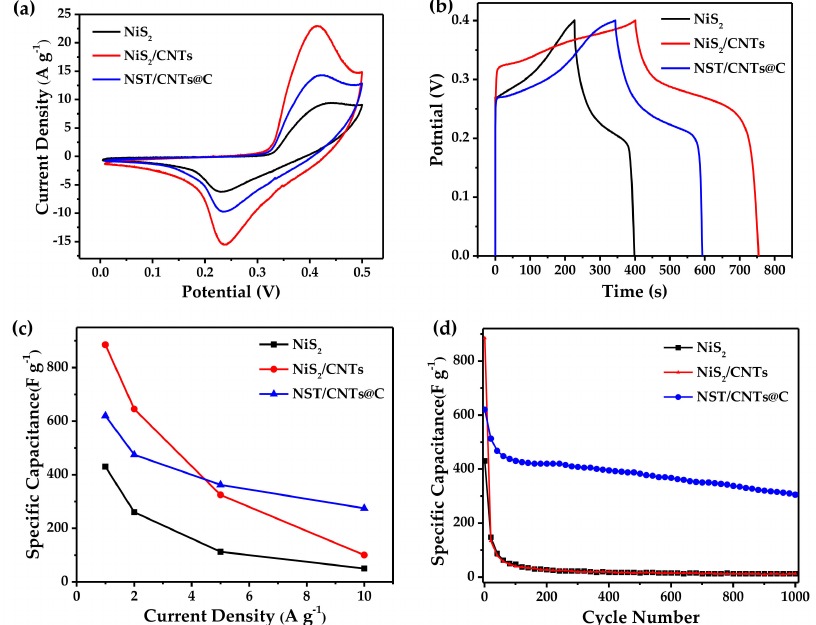
Figure 5. ( a ) CV curves at a scan rate of 10 mV · s − 1 ; ( b ) GCD curves at a current density of 1 A · g − 1 ; ( c ) Specific capacitance at various current density; ( d ) Capacity retention during 1000 cycles of GCDat a current density of 1A · g − 1